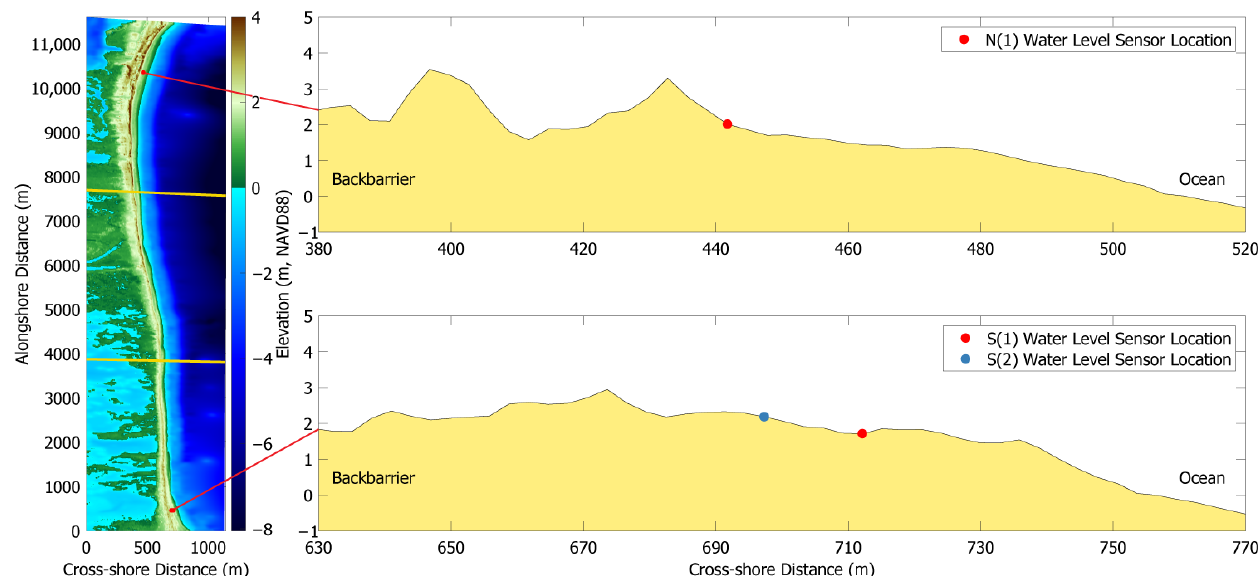
Figure 2. Pressure sensor locations on the XBeach model domain ( left ) and cross-shore elevation transects ( right ) at the north and south sections of Masonboro Island. Additional sensors were deployed on the dune crest and behind the dune (not shown) but did not record water levels. The yellow lines on the XBeach model domain divide the northern, central, and southern sections of the island used for statistical analyses.